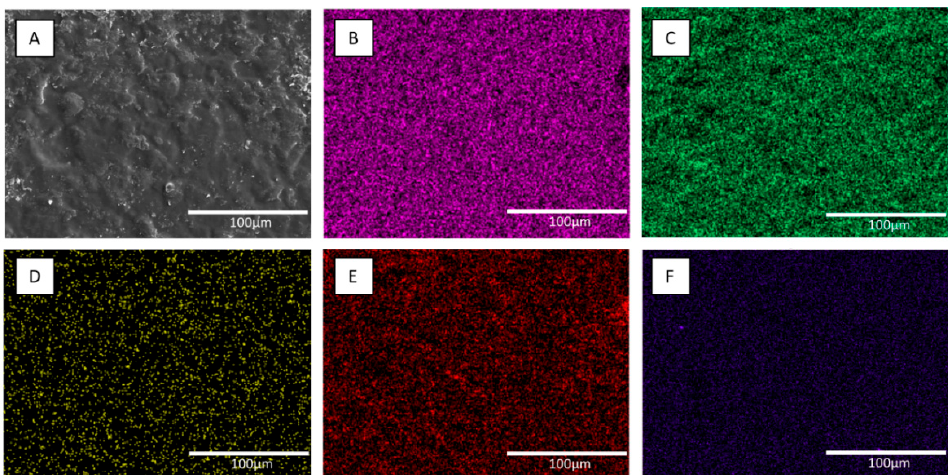
Figure 5. Scanning electron microscopy (SEM) and elemental (EDX) analysis of the 40% ChSi-nAg hybrid coating. SEM showed smooth undulating contours and microtopographies ( A ). EDX mapping detected a homogenous distribution of silicon ( B ), oxygen ( C ), nitrogen ( D ), carbon ( E ) and silver ( F ). The SEM/EDX analyses were representative and consistent across all coatings. Scale bar: 100 µm.